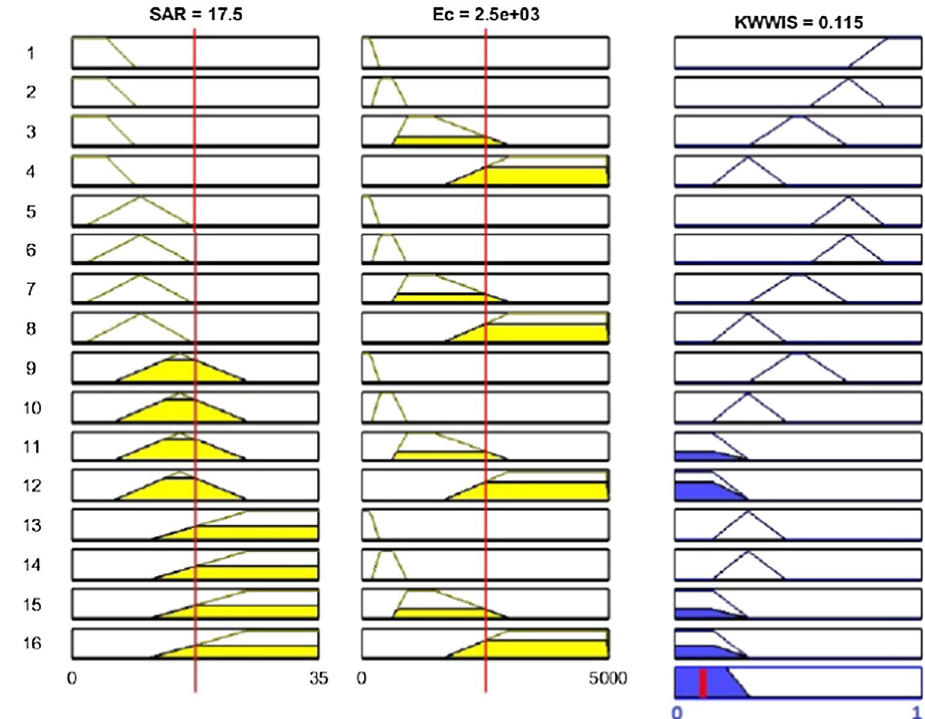
Fig. 1 Fuzzy logic interference system (rule